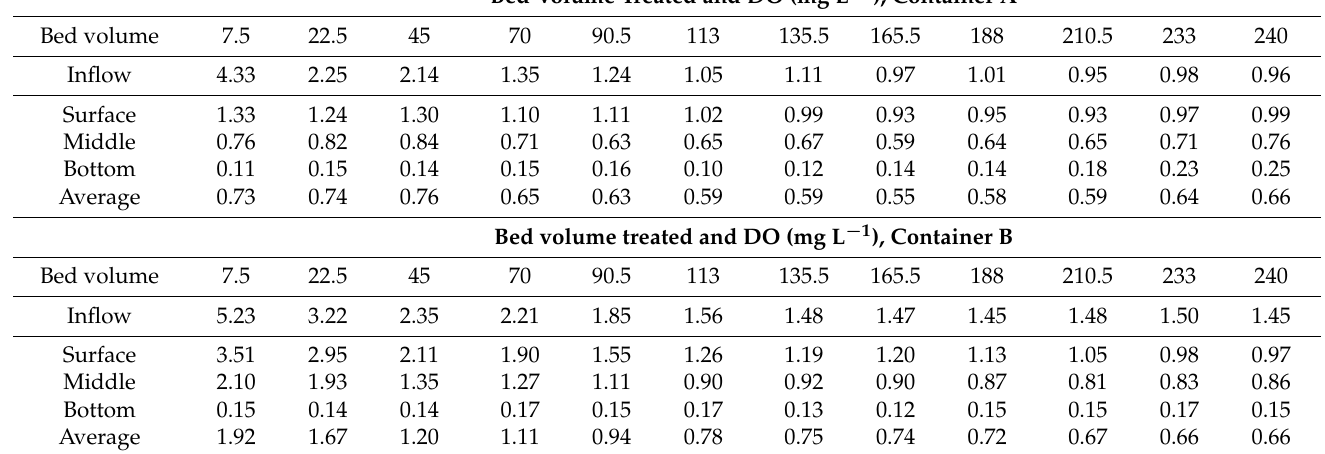
Table 4. Development of DO concentrations in container A (Polonite filtration) and B (glass bead filtration) during 32 days pumping of hypolimnetic water. DO was measured in the center of the containers at three depths, and water was collected at the inflow to the containers. Each value represents one measurement, and mean values are given for the water column in relation to the number of BV volume of